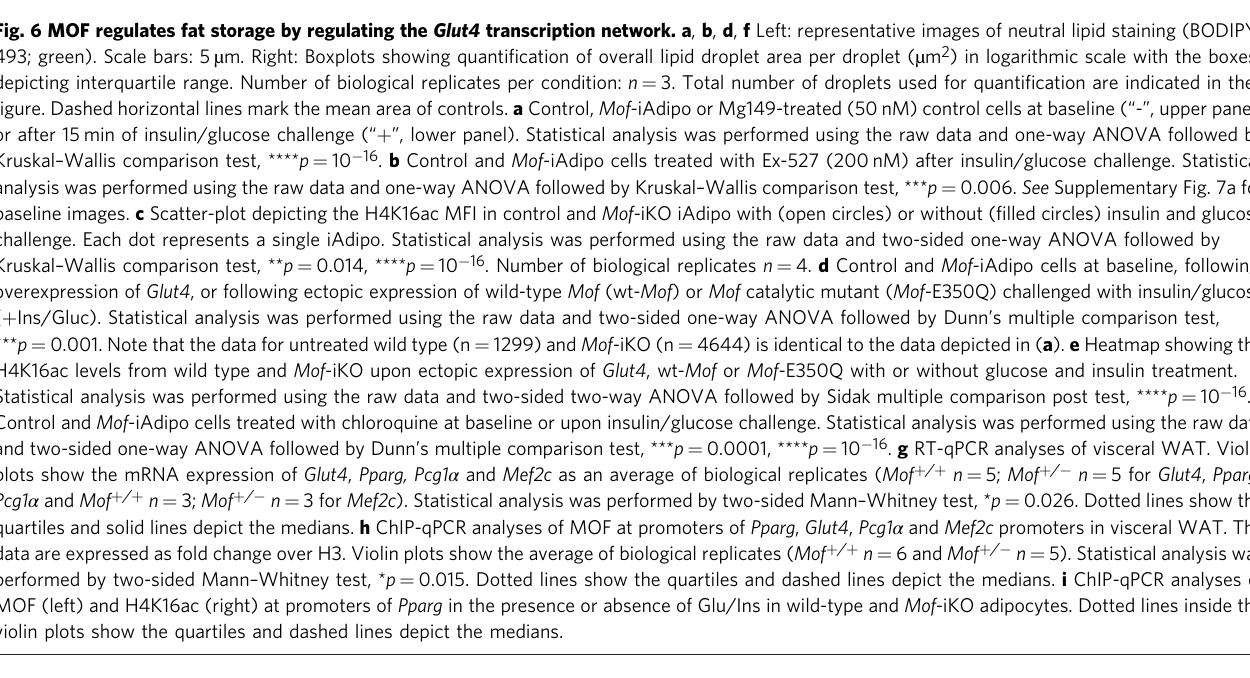
Fig. 6 MOF regulates fat storage by regulating the Glut4 transcription network. a , b , d , f Left: representative images of neutral lipid staining (BODIPY- 493; green). Scale bars: 5 µ m. Right: Boxplots showing quanti fi cation of overall lipid droplet area per droplet ( µ m 2 ) in logarithmic scale with the boxes depicting interquartile range. Number of biological replicates per condition: n = 3. Total number of droplets used for quanti fi cation are indicated in the fi gure. Dashed horizontal lines mark the mean area of controls. a Control, Mof -iAdipo or Mg149-treated (50 nM) control cells at baseline ( “ - ” , upper panel) or after 15 min of insulin/glucose challenge ( “ + ” , lower panel). Statistical analysis was performed using the raw data and one-way ANOVA followed by Kruskal – Wallis comparison test, **** p = 10 − 16 . b Control and Mof -iAdipo cells treated with Ex-527 (200 nM) after insulin/glucose challenge. Statistical analysis was performed using the raw data and one-way ANOVA followed by Kruskal – Wallis comparison test, *** p = 0.006. See Supplementary Fig. 7a for baseline images. c Scatter-plot depicting the H4K16ac MFI in control and Mof- iKO iAdipo with (open circles) or without ( fi lled circles) insulin and glucose challenge. Each dot represents a single iAdipo. Statistical analysis was performed using the raw data and two-sided one-way ANOVA followed by Kruskal – Wallis comparison test, ** p = 0.014, **** p = 10 − 16 . Number of biological replicates n = 4. d Control and Mof -iAdipo cells at baseline, following overexpression of Glut4 , or following ectopic expression of wild-type Mof (wt- Mof ) or Mof catalytic mutant ( Mof -E350Q) challenged with insulin/glucose ( + Ins/Gluc). Statistical analysis was performed using the raw data and two-sided one-way ANOVA followed by Dunn ’ s multiple comparison test, *** p = 0.001. Note that the data for untreated wild type (n = 1299) and Mof -iKO (n = 4644) is identical to the data depicted in ( a ). e Heatmap showing the H4K16ac levels from wild type and Mof -iKO upon ectopic expression of Glut4 , wt- Mof or Mof -E350Q with or without glucose and insulin treatment. Statistical analysis was performed using the raw data and two-sided two-way ANOVA followed by Sidak multiple comparison post test, **** p = 10 − 16 . f Control and Mof -iAdipo cells treated with chloroquine at baseline or upon insulin/glucose challenge. Statistical analysis was performed using the raw data and two-sided one-way ANOVA followed by Dunn ’ s multiple comparison test, *** p = 0.0001, **** p = 10 − 16 . g RT-qPCR analyses of visceral WAT. Violin plots show the mRNA expression of Glut4 , Pparg, Pcg1 α and Mef2c as an average of biological replicates ( Mof + / + n = 5; Mof + / − n = 5 for Glut4 , Pparg, Pcg1 α and Mof + / + n = 3; Mof + / − n = 3 for Mef2c ). Statistical analysis was performed by two-sided Mann – Whitney test, * p = 0.026. Dotted lines show the quartiles and solid lines depict the medians. h ChIP-qPCR analyses of MOF at promoters of Pparg , Glut4 , Pcg1 α and Mef2c promoters in visceral WAT. The data are expressed as fold change over H3. Violin plots show the average of biological replicates ( Mof + / + n = 6 and Mof + / − n = 5). Statistical analysis was performed by two-sided Mann – Whitney test, * p = 0.015. Dotted lines show the quartiles and dashed lines depict the medians. i ChIP-qPCR analyses of MOF (left) and H4K16ac (right) at promoters of Pparg in the presence or absence of Glu/Ins in wild-type and Mof -iKO adipocytes. Dotted lines inside the violin plots show the quartiles and dashed lines depict the